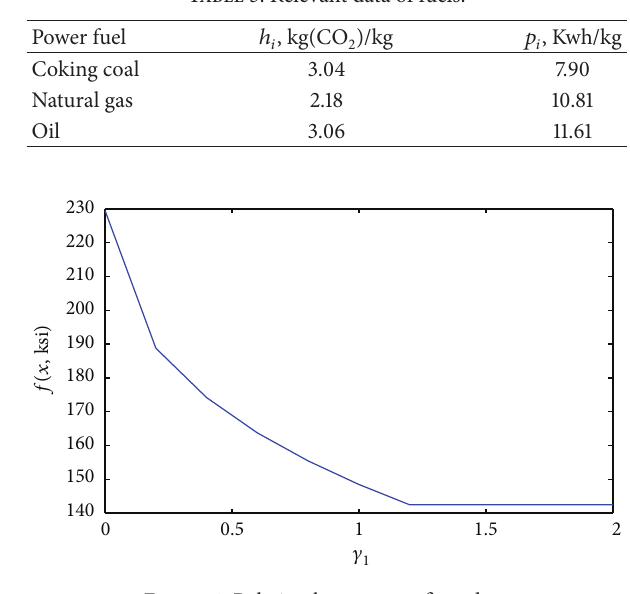
Figure 1: Relation between profit and 𝛾 1